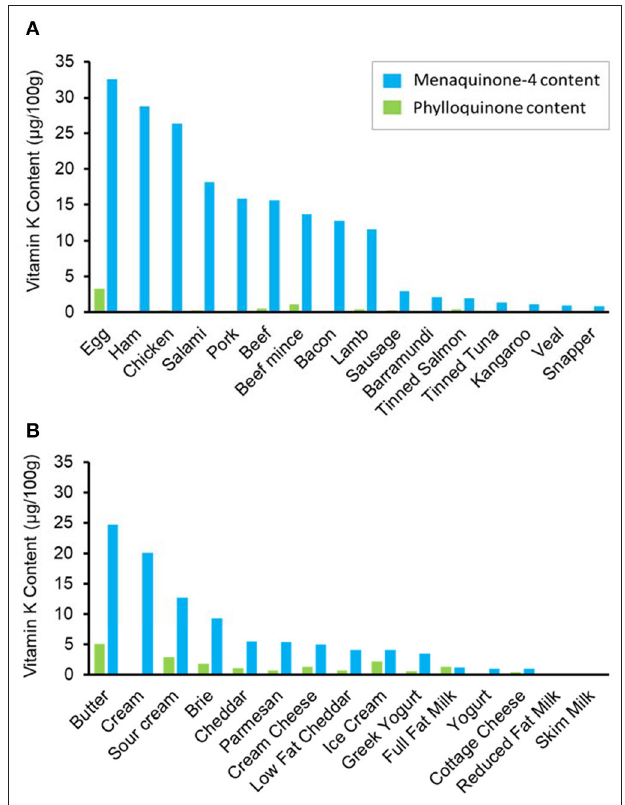
FIGURE 2 | Median menaquinone-4 (blue) and phylloquinone (green) content of (A) meat products and (B) dairy products. Presented from highest to lowest menaquinone